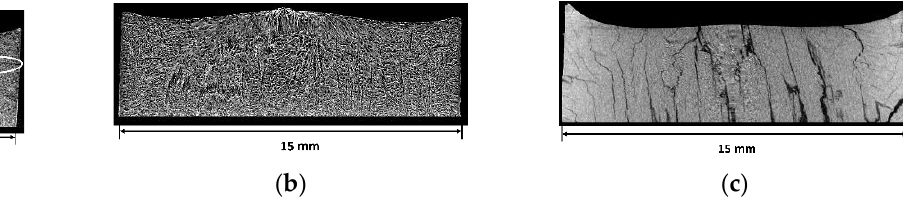
Figure 3. µ-CT imaging of the complete samples from in operando freeze-drying, with voxel sizes of 8 µm: ( a ) MD5, ( b ) M5 AN and ( c ) MD30. The images in ( a ) and ( c ) clearly reveal cracks propagating through the samples.